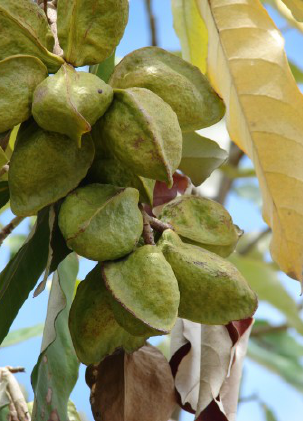
Figure 3. Heritiera littoralis